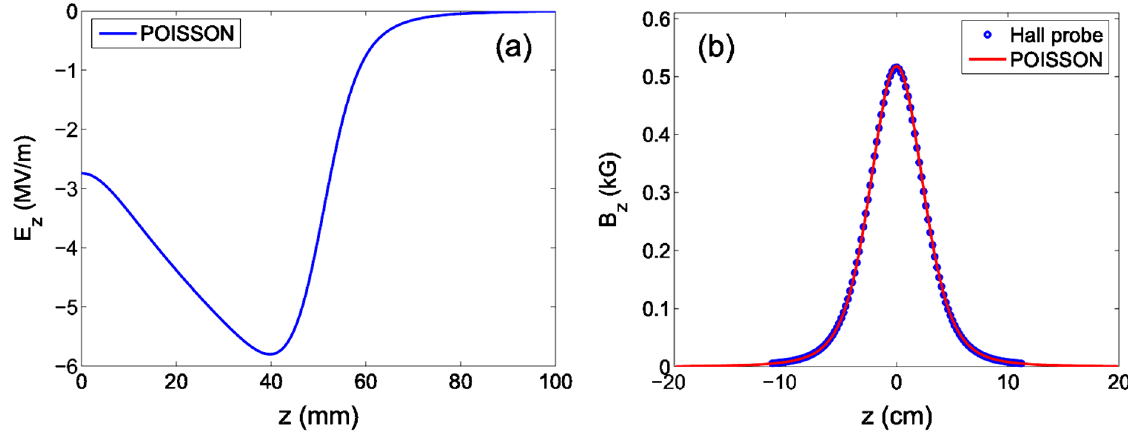
FIG. 2. (Color) Field profiles for (a) the dc gun at 250 kV and (b) the solenoid with 5 A excitation